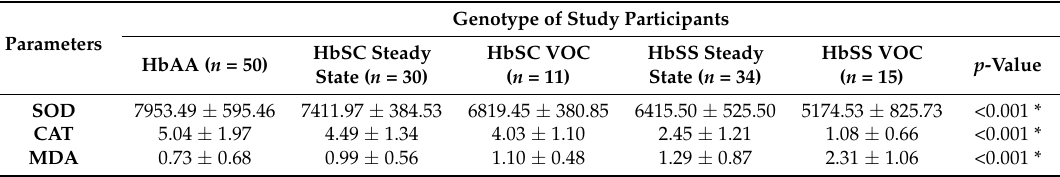
Table 2. Levels of oxidative stress markers of the study